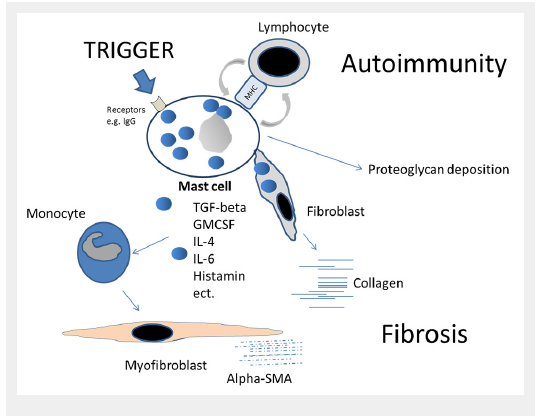
Schematic illustration of mast cells as key players in fibrosis. After stimulation by a trigger, e.g., IgG molecules, mast cells induce profibrotic cytokines or growth factors. Fibroblasts are stimulated and monocytes differentiate into myofibroblasts. Proteoglycans can be directly released by the mast cell in the surrounding matrix. Antigen-presentation to lymphocytes might induce autoimmunity. The suppression of mast cell degranulation by T-regulatory cells under physiological conditions can be impaired in chronic